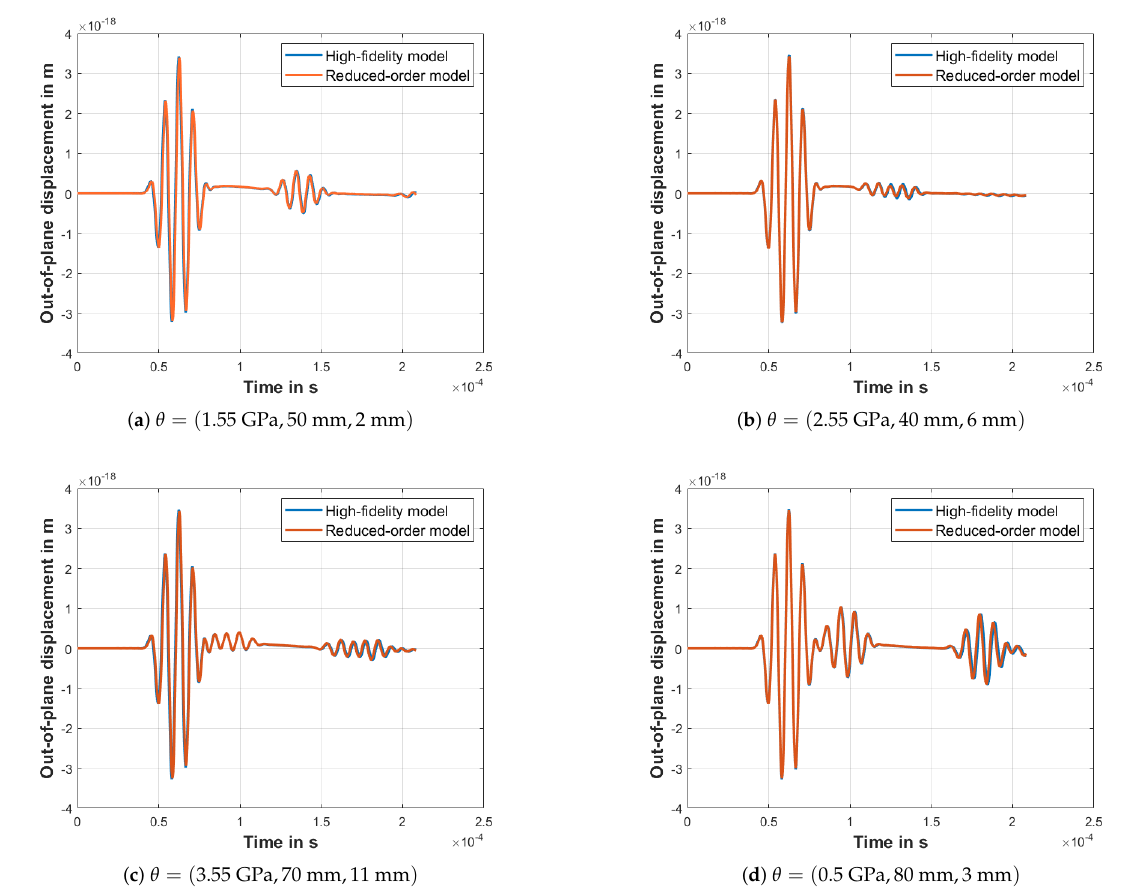
Figure 5. The comparison of low-dimensional solution with Hi-Fi solution for four different parameter configurations in D . The evolution of residual-based a posteriori error indicator and relative error between the Hi-Fi model and the low-dimensional model are shown in Figure 6a,b, respectively. modes implying the fine approximation of global projection matrix.